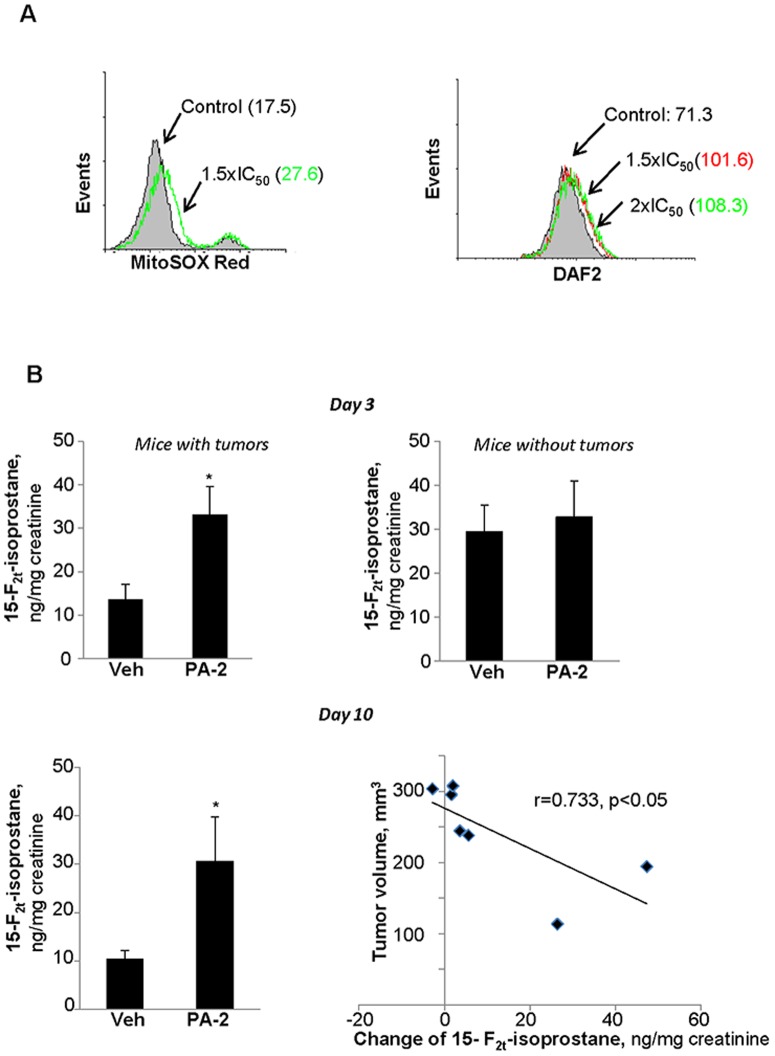
Phospho-aspirin-2 induces oxidative stress.
A:
Left: Mitochondria superoxide was measured by MitoSOX Red dye after treatment of MCF7 cells with PA-2. Right: Nitric oxide levels was determined by DAF2 staining after treatment with PA-2. B: The levels of 15-F2t-isoprostane in 24-h urine of nude mice were determined using an enzyme-linked immunosorbent assay kit. Left: results from nude mice bearing MCF7 xenografts on day 3 (top) and day 10 (bottom). Right: results from nude mice bearing no xenografts on day 3 (top). The association between tumor volume and urinary 15-F2t-isoprostane levels in the nude mice from the xenograft study is shown (bottom).